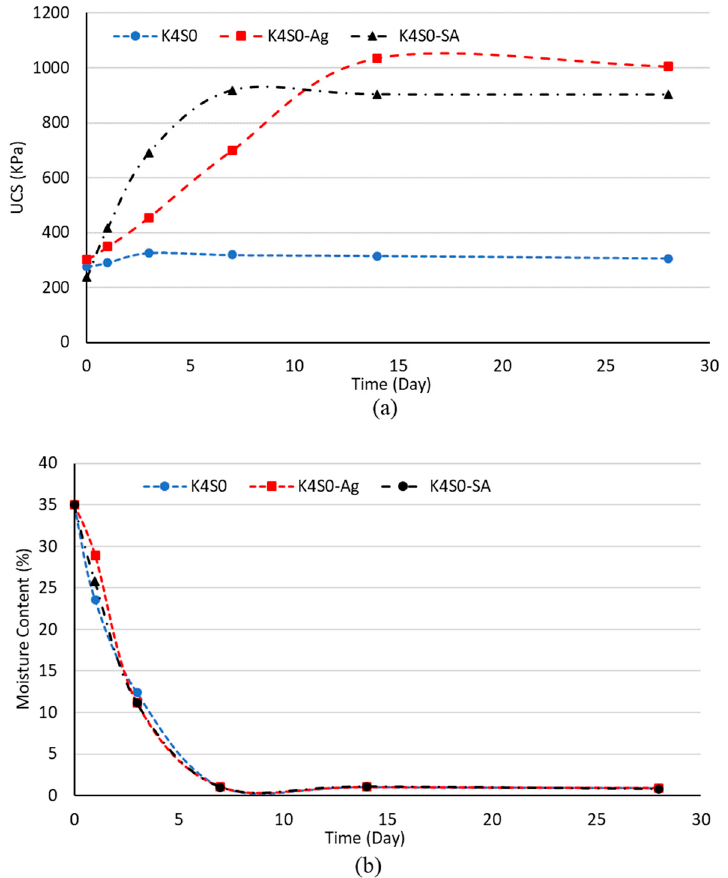
Figure 3. E ff ect of dehydration time on biopolymer-treated K4S0 ( a ) UCS, ( b ) moisture level. Figure 3. Effect of dehydration time on biopolymer-treated K4S0 ( a ) UCS, ( b ) moisture